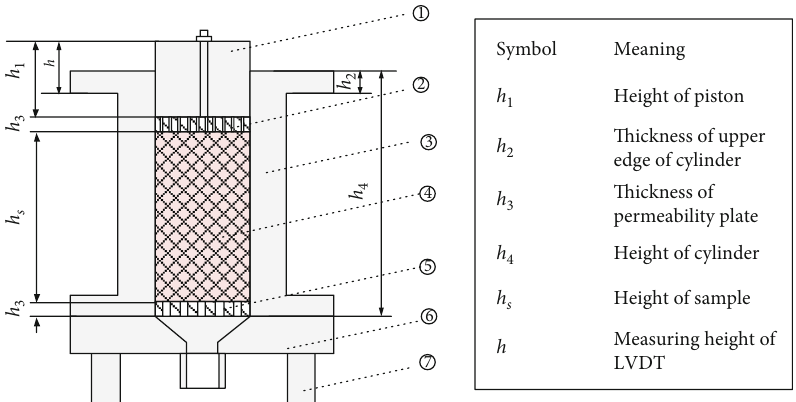
Figure 4: The structure of erosion unit. Note: ① piston, ② upper seepage plate, ③ cylinder, ④ sample, ⑤ lower seepage plate, ⑥ conical bottom plate, and ⑦